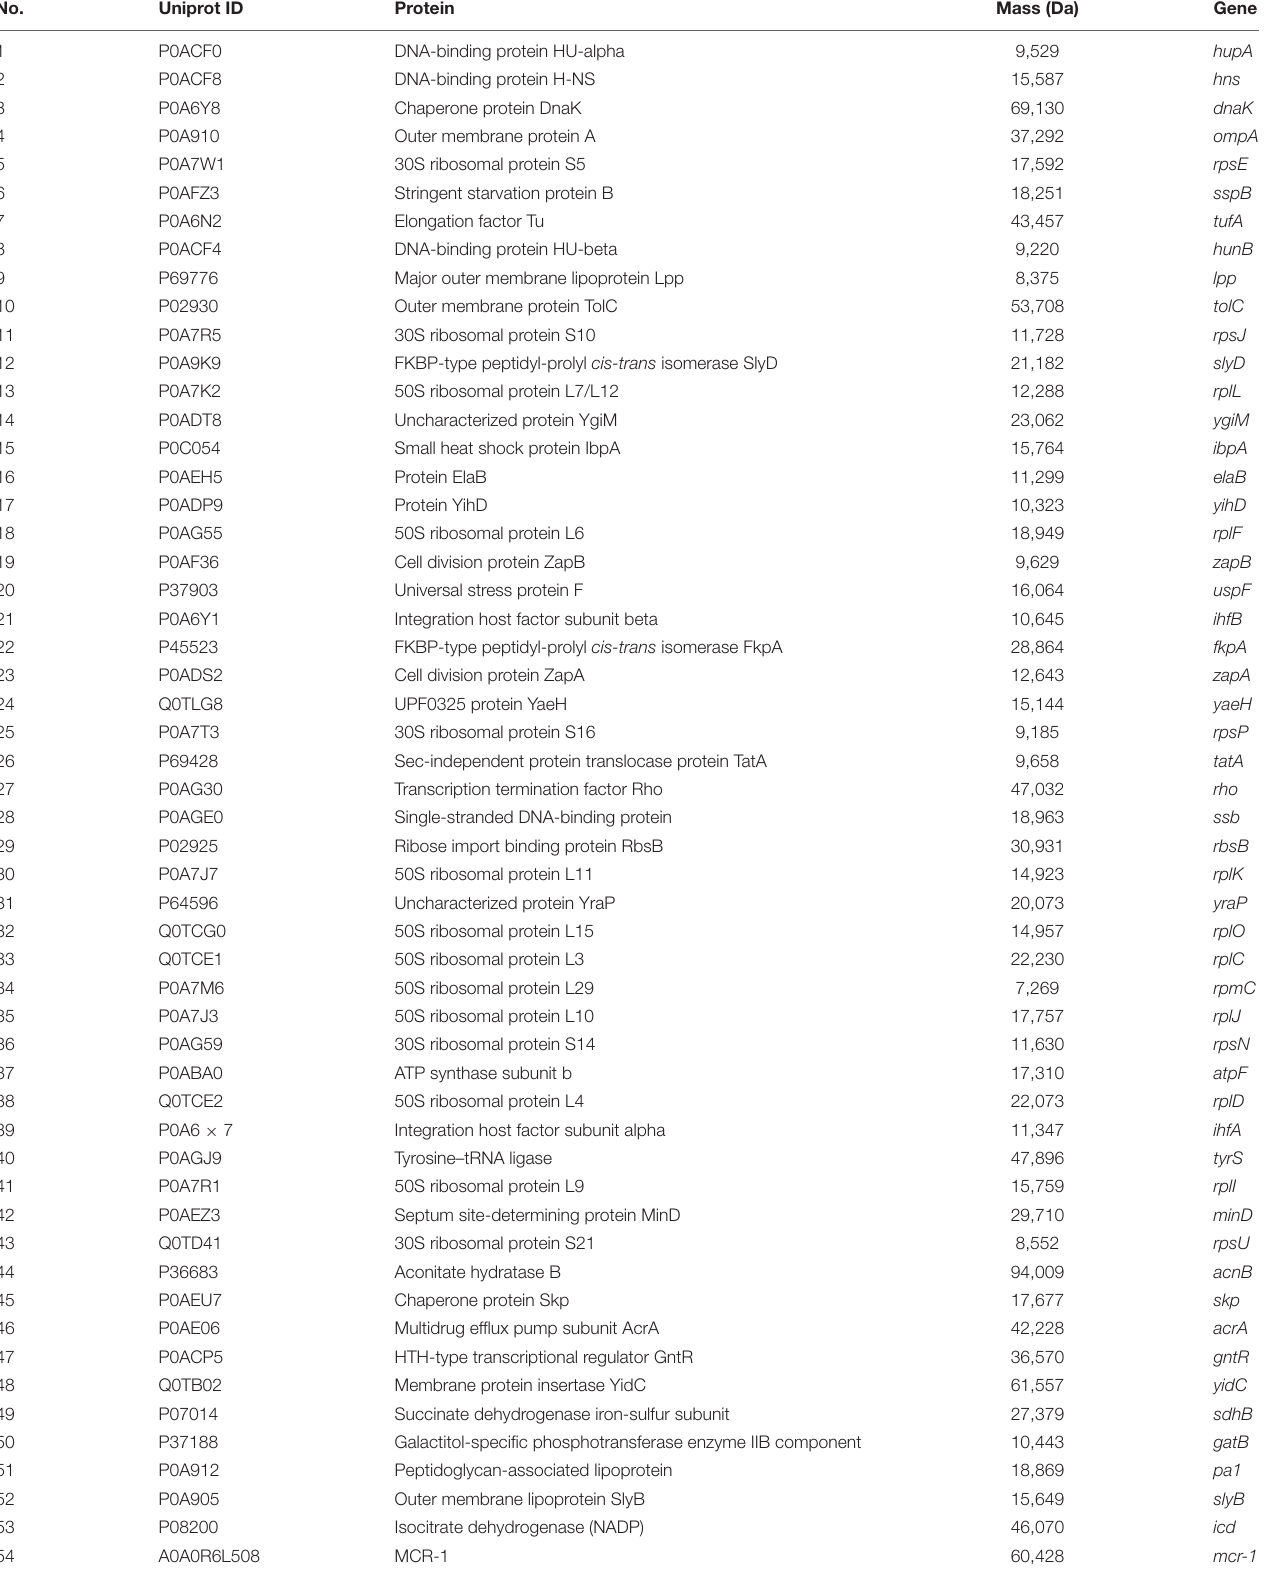
TABLE 2 | MCR-1 protein interactors identified in E. coli BL21 (DE3) (pET28a-mcr-1).